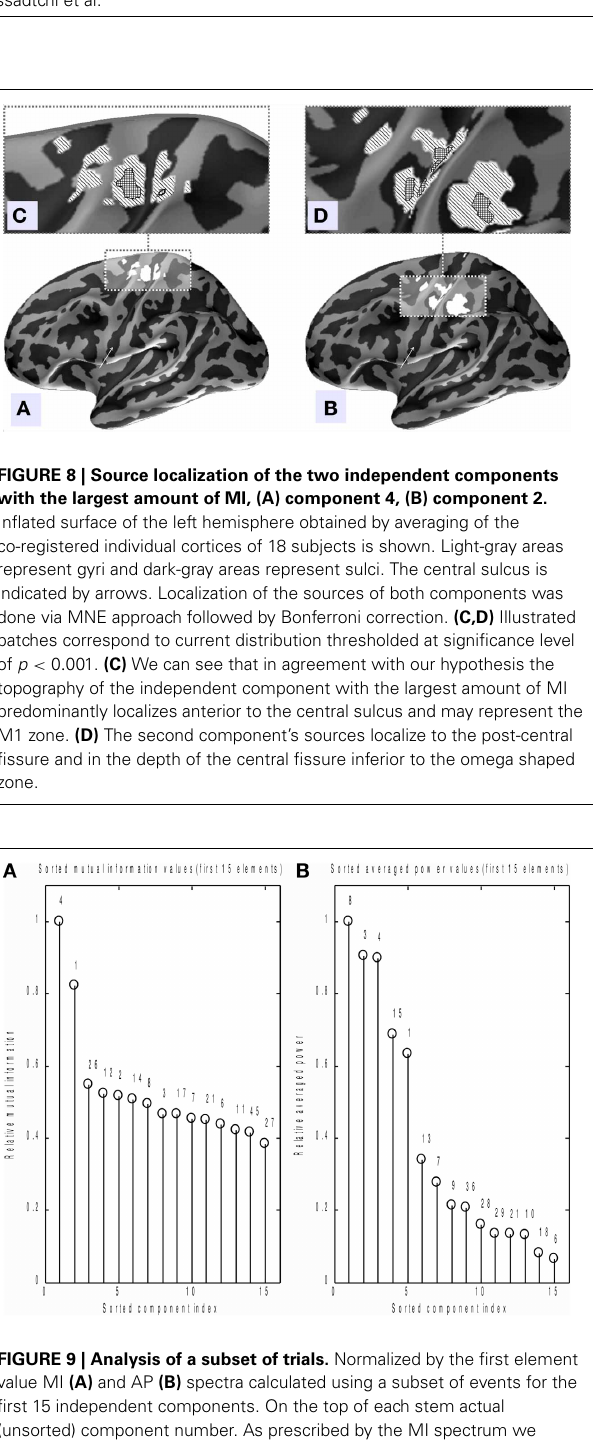
the averages obtained for the other three components suggested by the AP spectrum does not reveal the presence of signifi- cant amount of stimulus-locked activity in three out of five